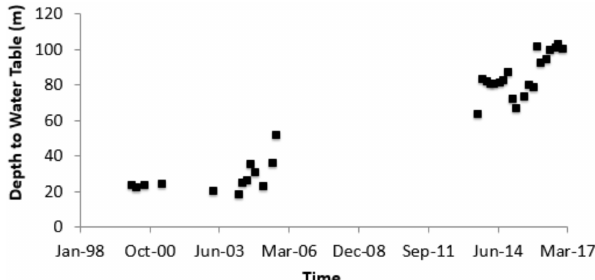
Figure 2. The variation in the depth to water table for a specific well in the Eocene aquifer (based on the database of the Palestinian Water Authority).